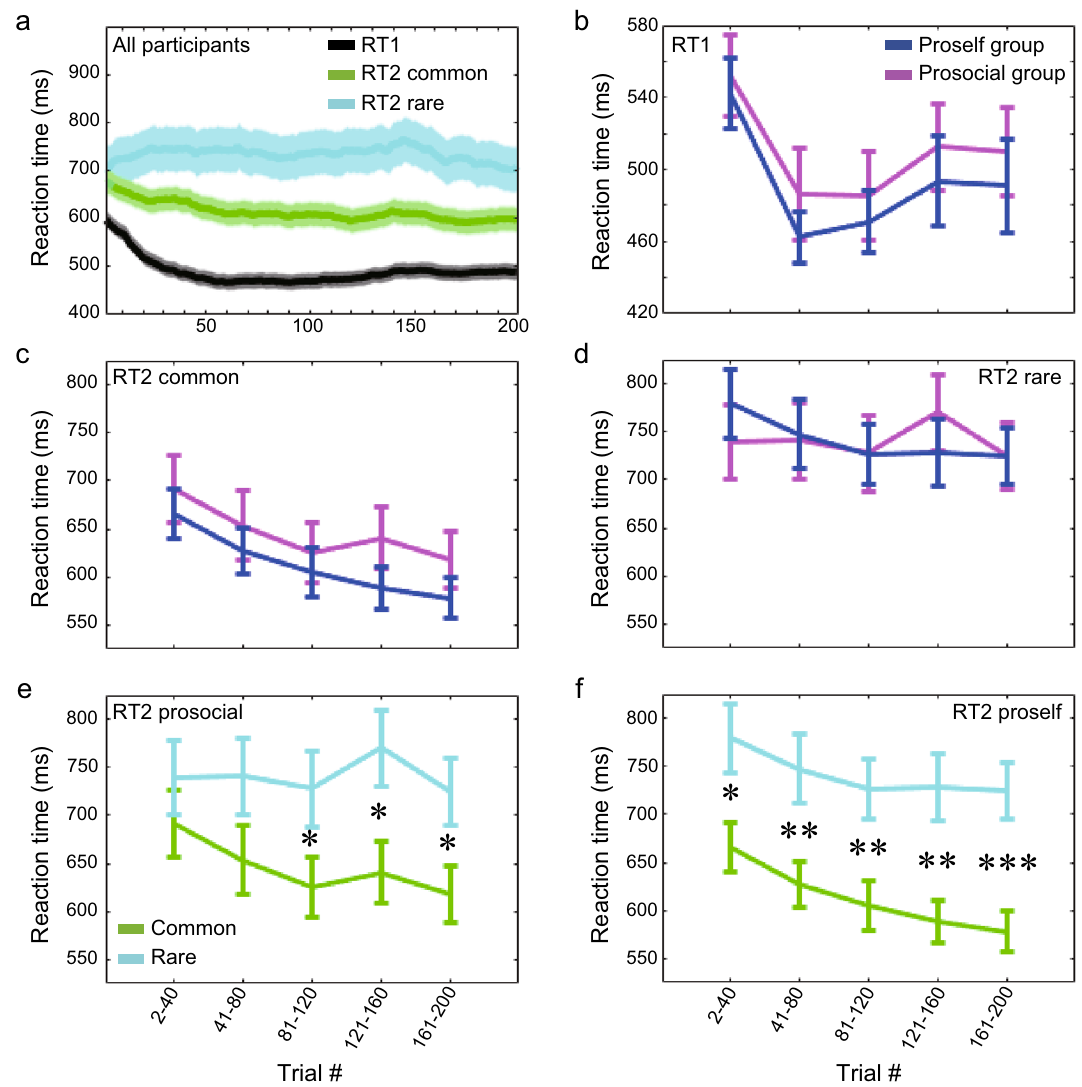
Figure 4. Comparing reaction times between the proself and prosocial groups. ( a ) Reaction times averaged across all participants for the first choice (RT1: black), the second choice after common transitions (RT2 common: green), and the second choice after rare transitions (RT2 rare: cyan). Shaded error bar represents SEM. ( b ) Averaged reaction times per 40 trials at the first choice, divided into the proself and prosocial groups. Blue indicates the proself group. Magenta indicates the prosocial group. Error bar indicates SEM. ( c ) RTs at the second choice after common transitions, ( d ) RTs at the second choice after rare transitions, ( e ) RTs at the second choice of the prosocial group divided into after common and rare transitions. Green represents after common transitions, and cyan represents after rare transitions. ( f ) RTs at the second choice of the proself group. * p < 0.05, ** p < 0.01, *** p <